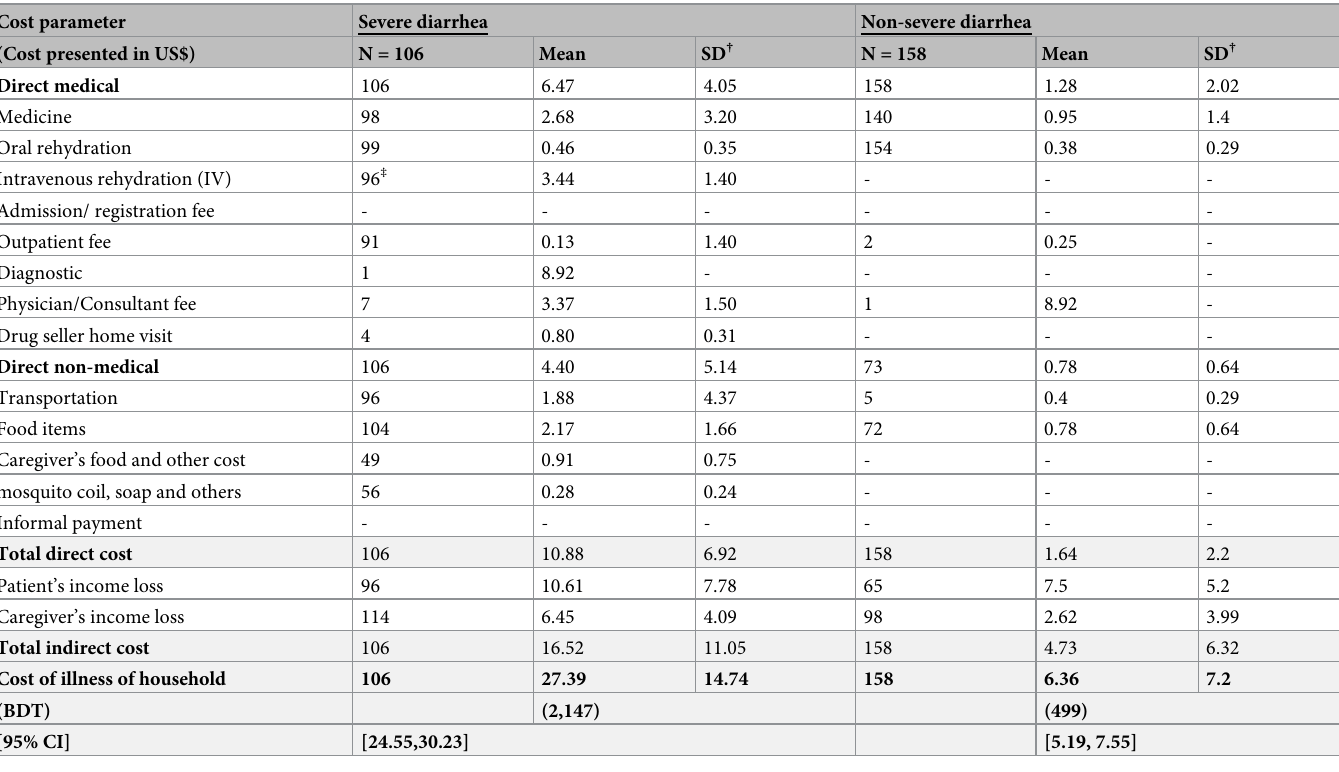
Table 2. Average household cost for severe and non-severe diarrhea of Tongi Township in Dhaka, Bangladesh from September 2015 to June 2016, US$ � . Cost parameter